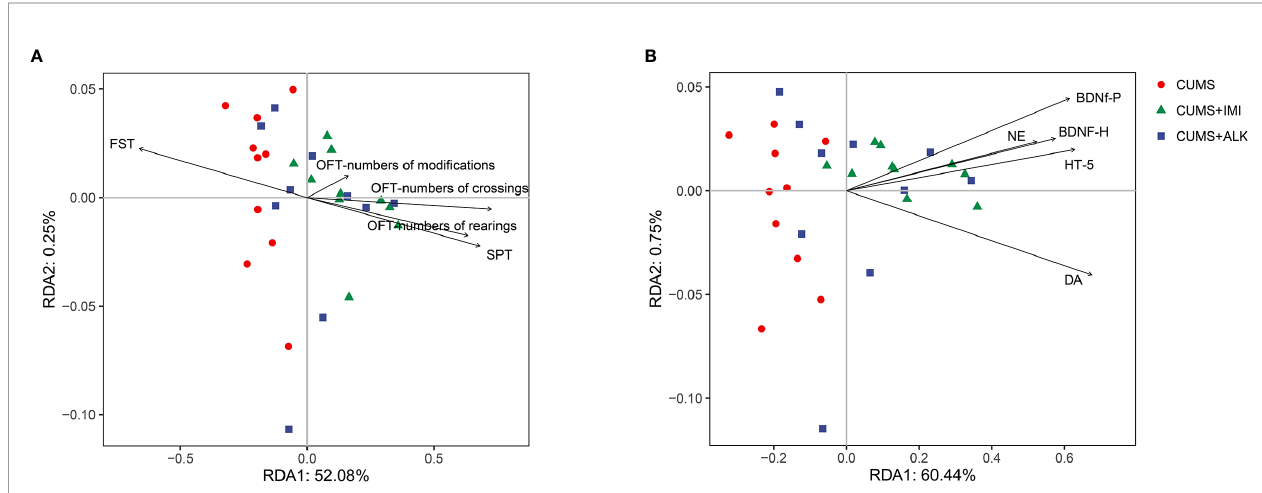
FIGURE 5 | Redundancy analysis (RDA) between gut microbiota, depression-like behaviors, and depression-related indicators. (A) RDA was performed to assess the contributions of the depression-like behaviors to the gut microbiota between different treatment groups. (B) RDA was performed to assess the contributions of the depression-related indicators to the gut microbiota between different treatment